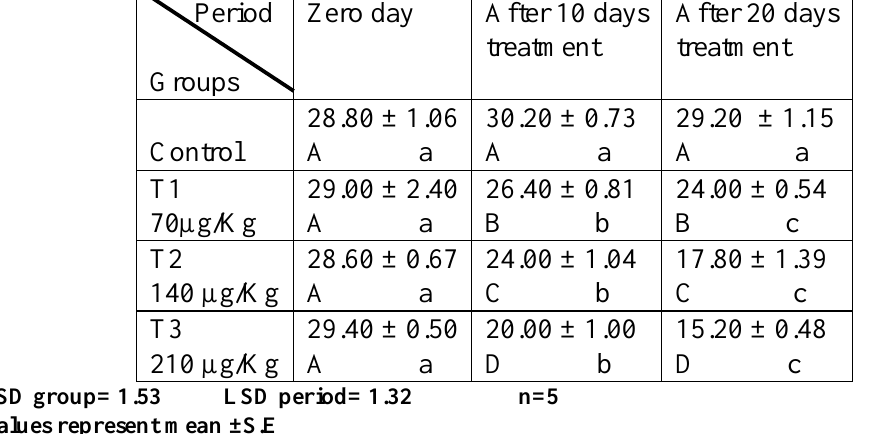
Table (4): GSH (µmol/L) in rats serum of different experimental groups dosed orally with ochratoxin A at different doses and